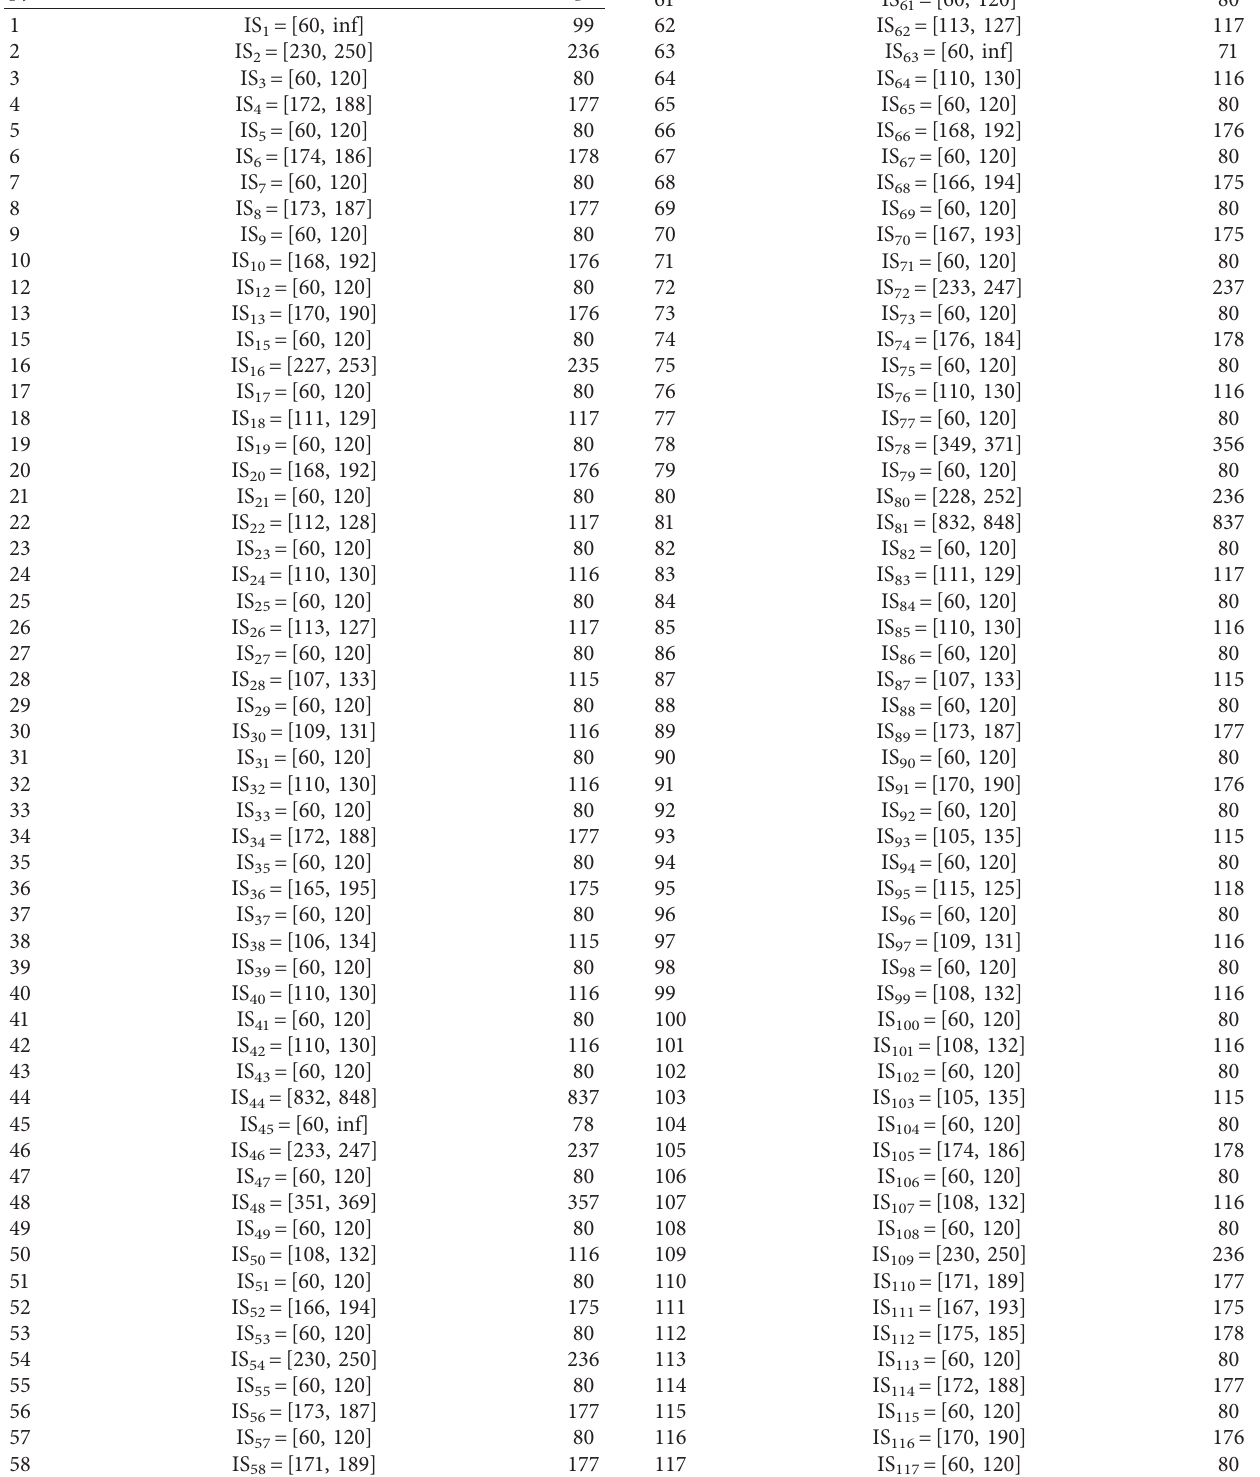
Table 2: The values of the static intervals IS i and the expected sojourn time of the token in the place p i